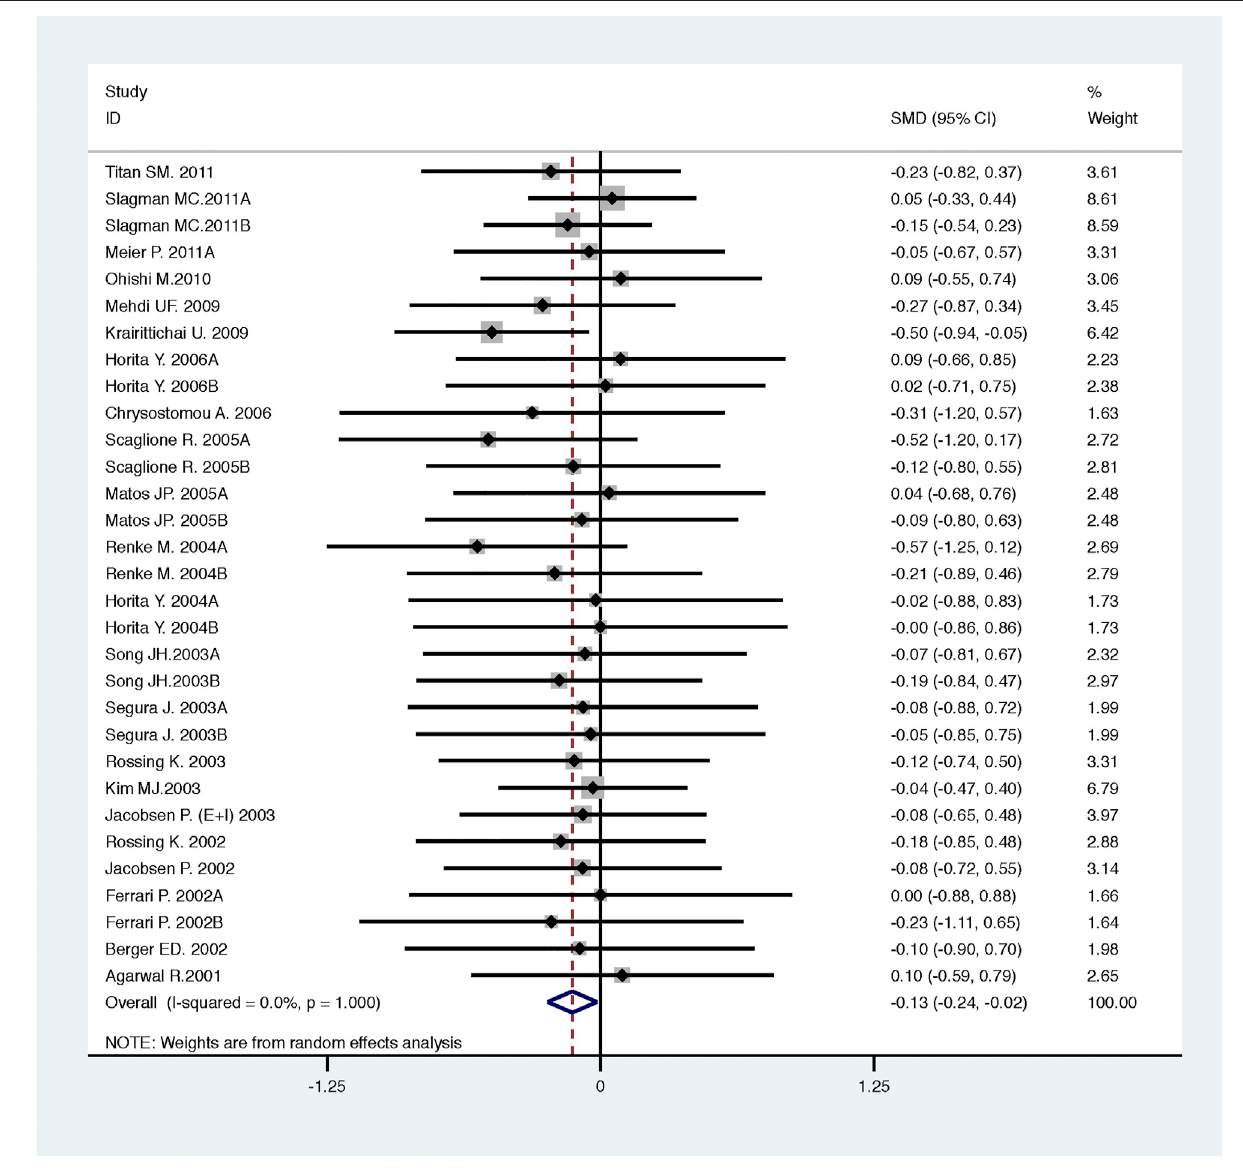
Frontiers in Pharmacology |